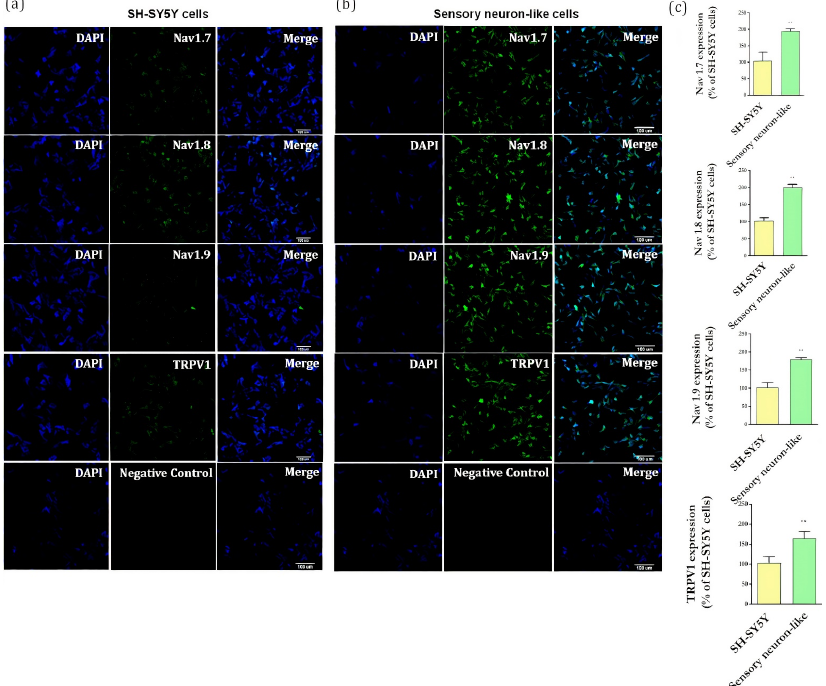
Figure 4. ( a ) Representative images of immunofluorescence of Nav1.7, Nav1.8, Nav1.9, and TRPV1 markers in undifferentiated cells (SH-SY5Y cells) and ( b ) in differentiated cells (sensory neuron-like cells). Magnification: 20×. Negative controls of immunostaining. Scale bar: 100 µm. ( c ) Quantification of Nav1.7, Nav1.8, Nav1.9, TRPV1 expression representing the ratio between the immunostaining in the differentiated cells (sensory neuron-like cells) and the in undifferentiated cells (SH-SY5Y cells). The data were analyzed by t -test, ** p < 0.001). The data represent three independent and similar